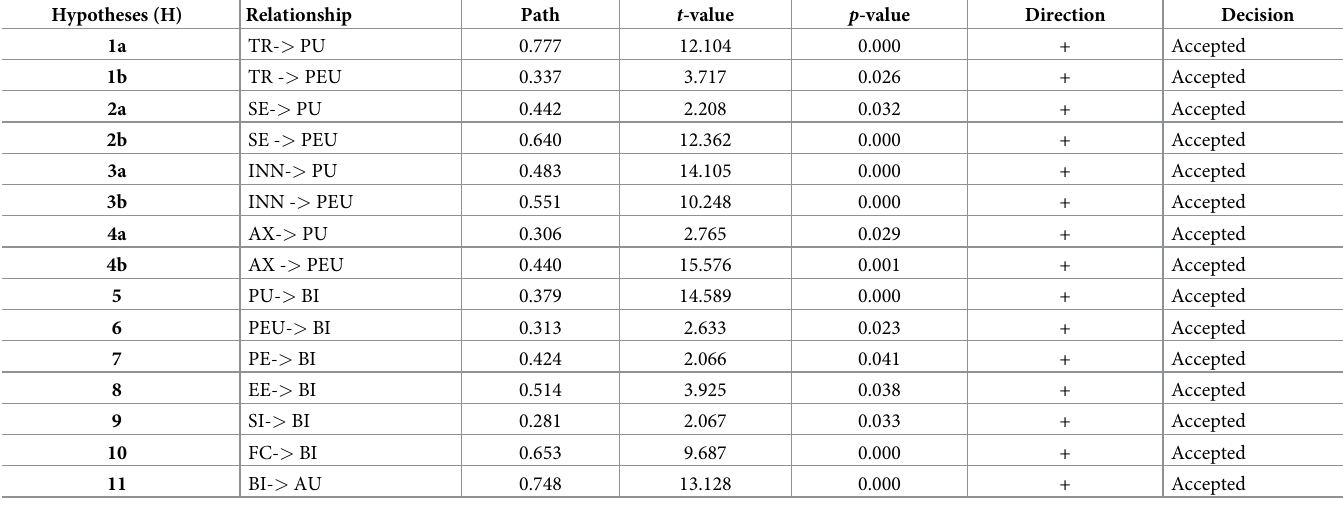
Table 7. Hypotheses-testing of the research